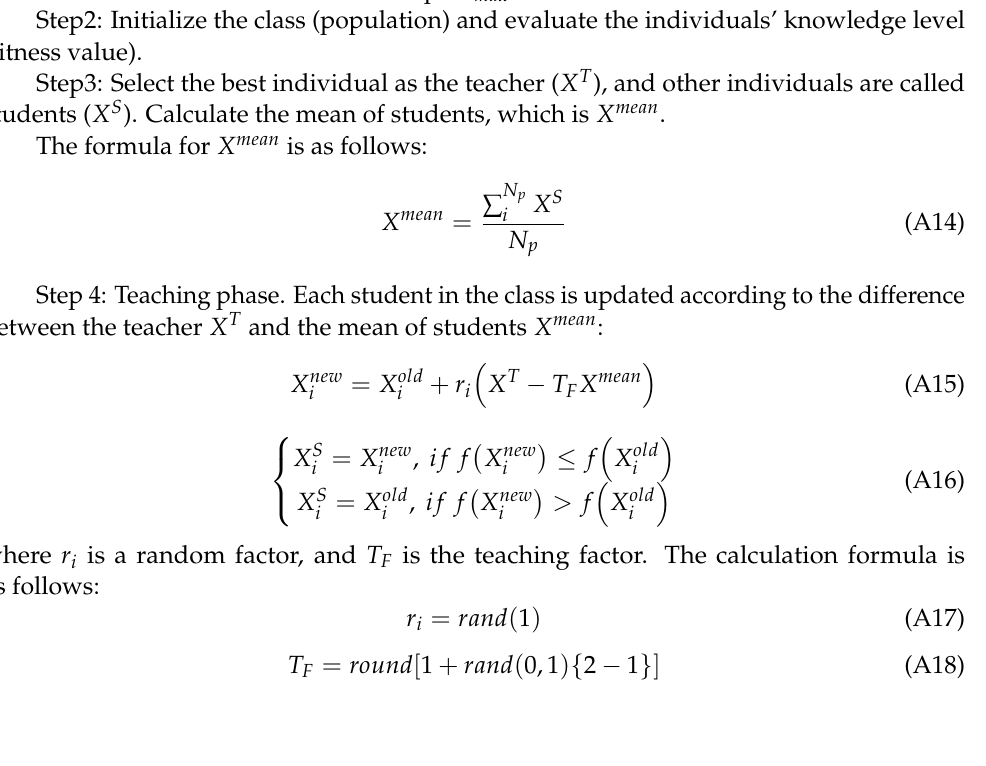
Figure A7. The fitting effect of the CST parameterization method for wing ( n = 5, m =